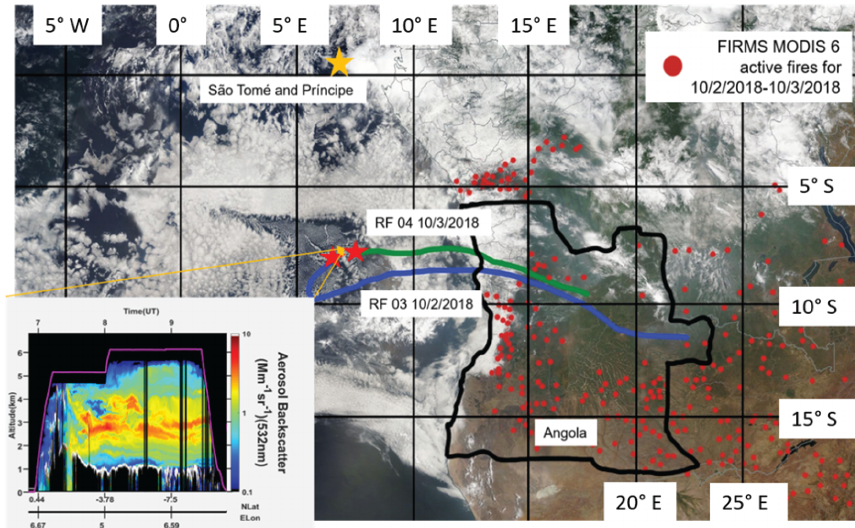
Figure 11. Ensemble-averaged NOAA HYSPLIT backward trajectories from RF 03 and RF 04 overlain with visible imagery of southern central Africa from the MODIS sensor aboard the Terra satellite for 2–3 October 2018 (source: image obtained from NASA NRT data archive). FIRMS MODIS 6 active fire hot spots for 2–3 October 2018 (red dots) are shown. The inset shows 532nm backscatter return signal from the HSRL lidar aboard the P-3 research aircraft, showing the vertical distribution of aerosols on 3 October 2018. The color scale indicates the aerosol backscattering coefficient, with boundary layer cloud tops as white and aerosols as green, yellow, and red (indicating low, medium, and high loads, respectively).